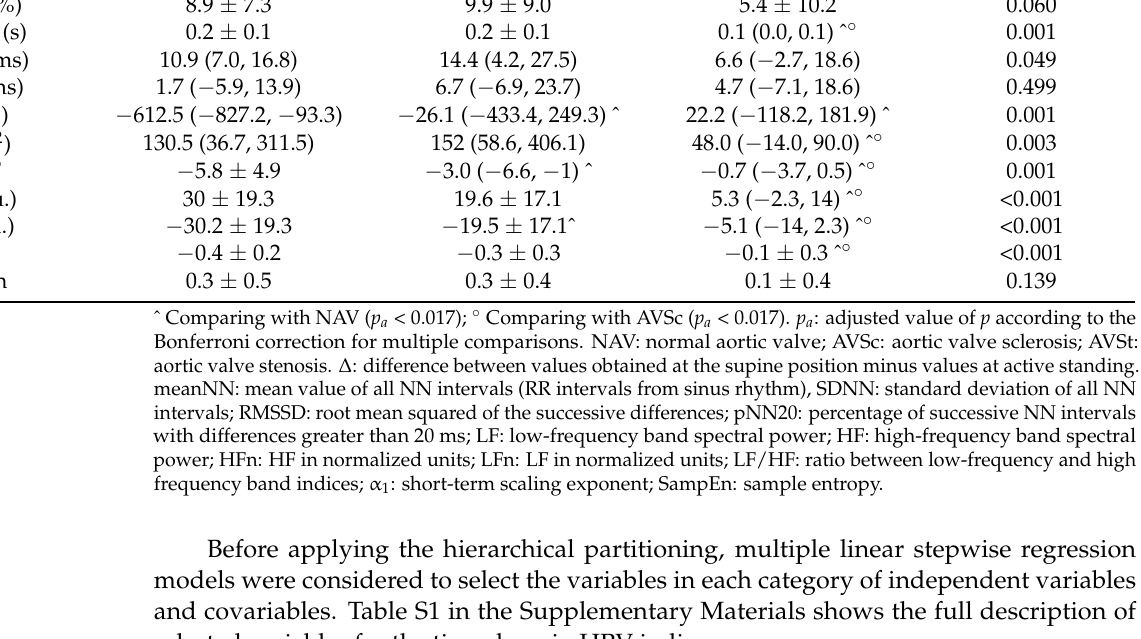
55 (51, 60) ˆ ◦ n = 32 216.9 ± 67.1 ˆ ◦ n = 15 119.8 ± 34.7 ˆ ◦ n = 15 0.5 ± 0.2 ˆ ◦ n = 15